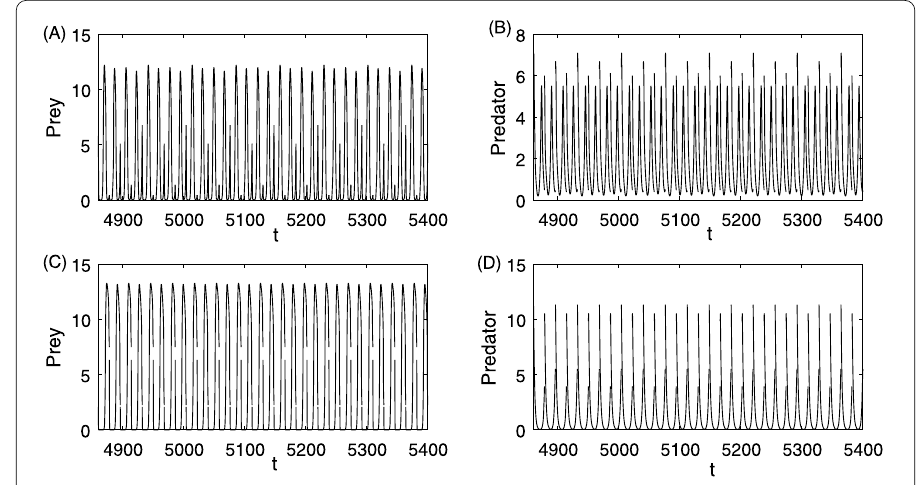
Figure 9 Two coexisting attractors of model (17) with δ = 0.31. The other parameter values are identical to those in Fig. 8. The initial conditions are: ( A – B )( x 0 , x 0 ) = (2.2,2.9);( C – D )( x 0 , x 0 ) = (2.7,2.5)